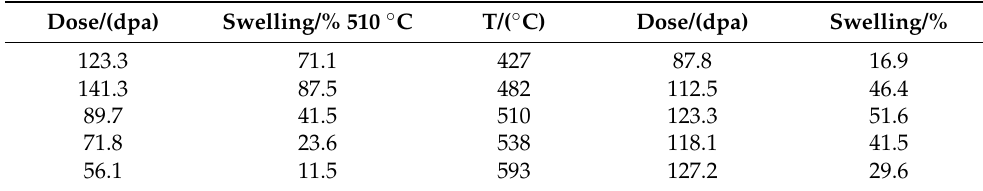
Table 4. Experimental data of neutron swelling in austenitic AISI 316 steel under different irradiation doses or at different temperatures from [29].